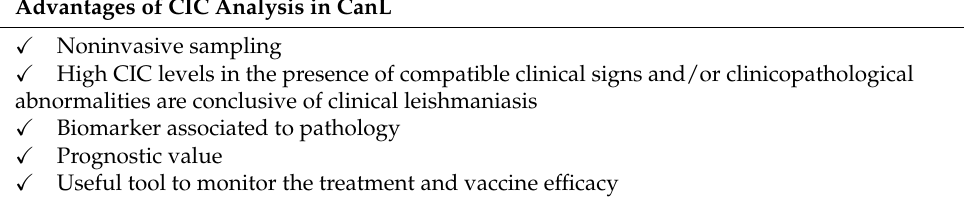
Table 2. Advantages of CIC analysis in